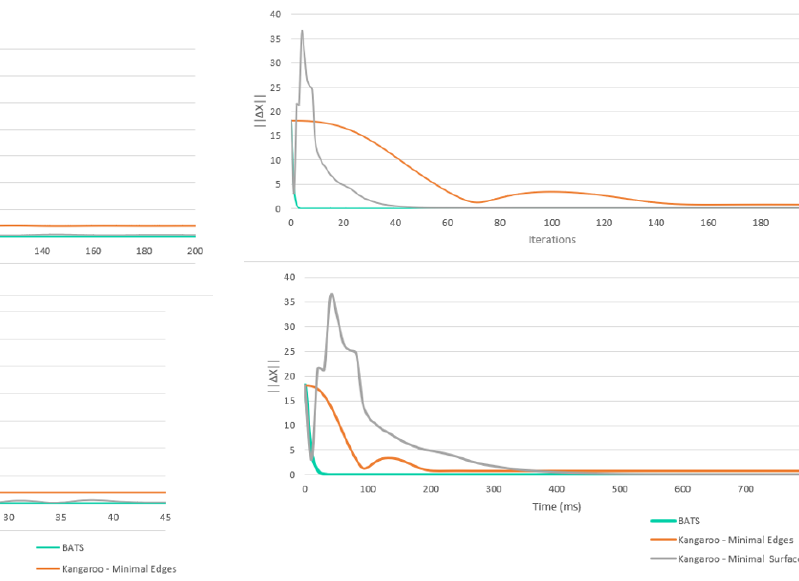
Figure 14: Iteration and time comparison for 50x50